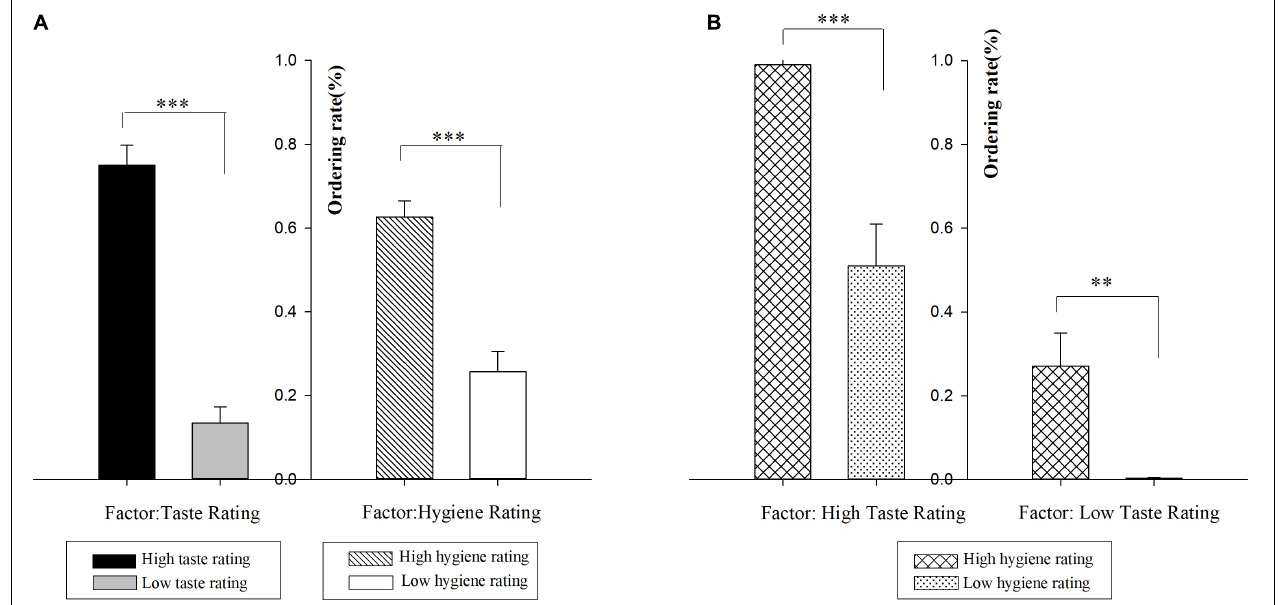
FIGURE 3 | Ordering rate results in Study 2. (A) The ordering rates organized according to one factor (taste rating or hygiene rating). (B) The ordering rates for all four experimental conditions. The error bars indicate standard error of the mean. ∗∗ p < 0.01 and ∗∗∗ p < 0.001.